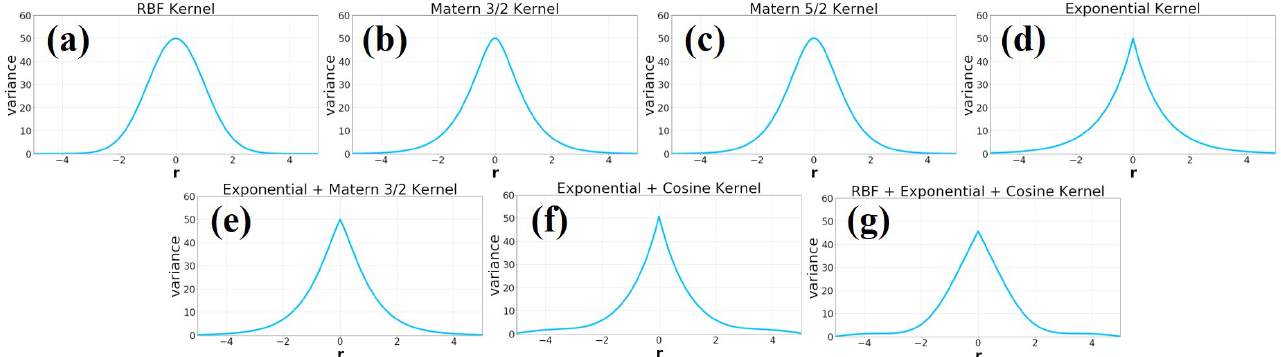
Figure 2. Differences in variance among the seven types of kernel functions proposed this time. r is the Euclidean distance of the input, r = | x p − x q | . ( a ) RBF Kernel ( b ) Exponential Kernel ( c ) Matern 3/2 Kernel ( d ) Matern 5/2 Kernel ( e ) Exponential + Cosine Kernel ( f ) Exponential + Matern 3/2 Kernel ( g ) RBF + Exponential + Cosine Kernel.